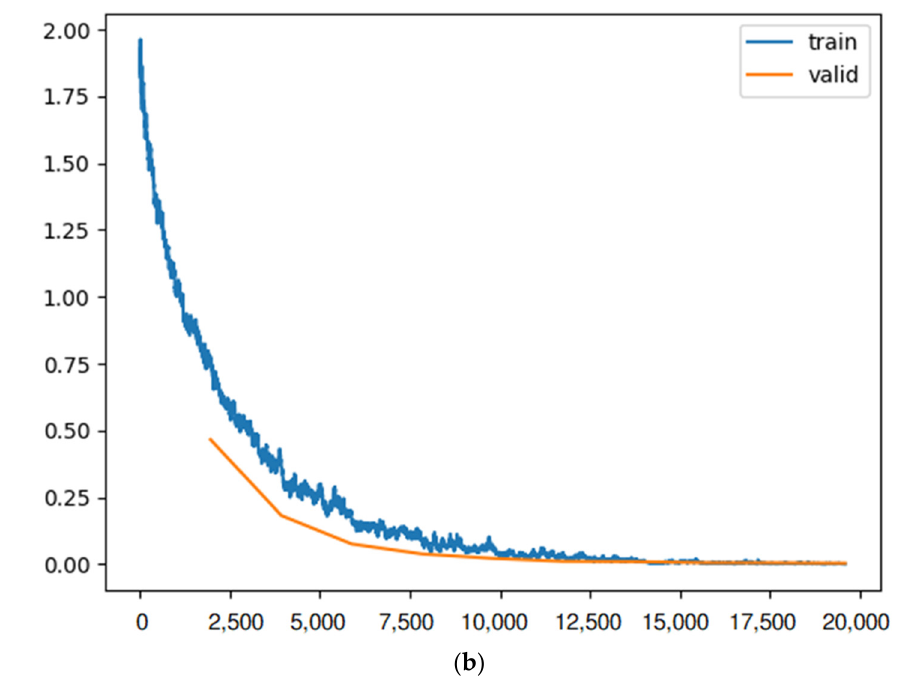
Figure 17. ( a ) Confusion matrix and ( b ) loss rate during training with XResNet5.